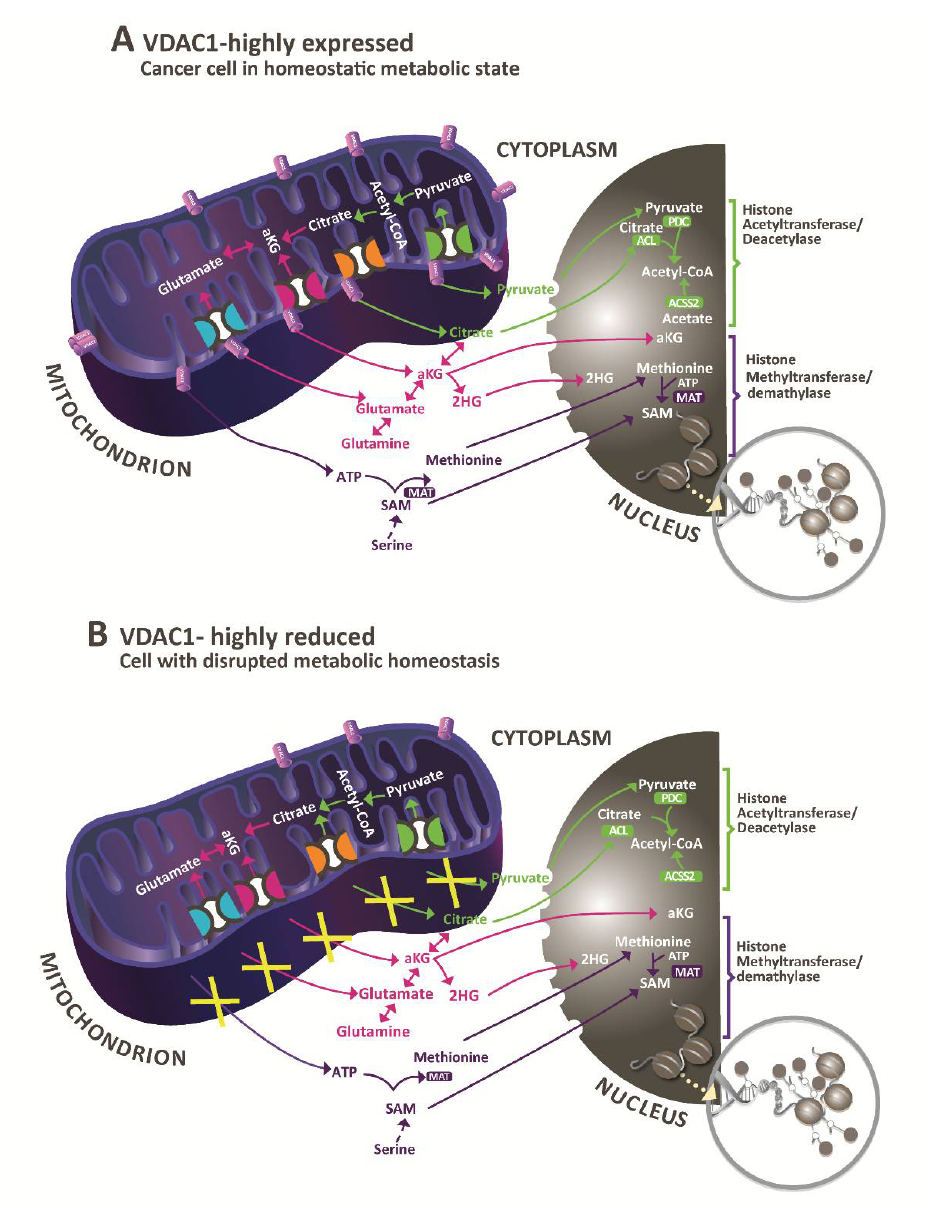
Figure 6. A simplified schematic depicting the interplay between mitochondrial VDAC1 metabolic pathways that provide substrates for enzymes that modify chromatin. ( A ) In cancer cells where the mitochondria have high levels of VDAC1, mitochondrial metabolic pathways generate carbon groups required for methylation (turquoise), acetylation (orange), or demethylation (dark blue) of chromatin. TCA cycle metabolites provide carbon units for both acetylation and demethylation via α-ketoglutarate (αKG). Metabolite transport across the inner mitochondrial membrane requires transporters that are shown. These metabolites, however, cross the outer mitochondrial membrane (OMM) via VDAC1 and the metabolites directly relevant to chromatin regulation reach the nucleus in which several metabolic enzymes are localized, including methionine adenosyl-transferase (MAT), ATP-citrate lyase (ACL), pyruvate dehydrogenase complex (PDC), and acetyl-CoA synthetase 2 (ACSS2). ( B ) Following VDAC1 depletion, there is a strong reduction in mitochondrial metabolism [44,46–48] due to the decrease in substrates transported into the mitochondria and the inability of the produced metabolites to exit the mitochondria. This limits the substrates for chromatin modifications. The scheme has been modified from [87] .